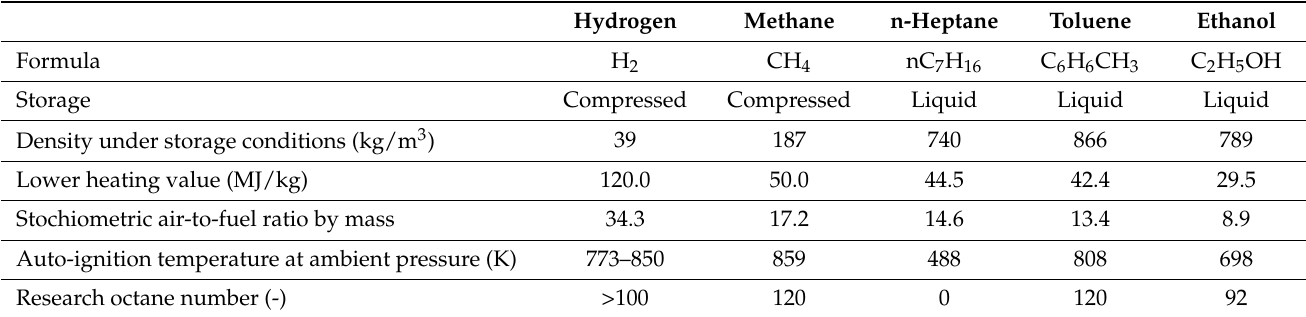
Table 2. Main properties of fuels under